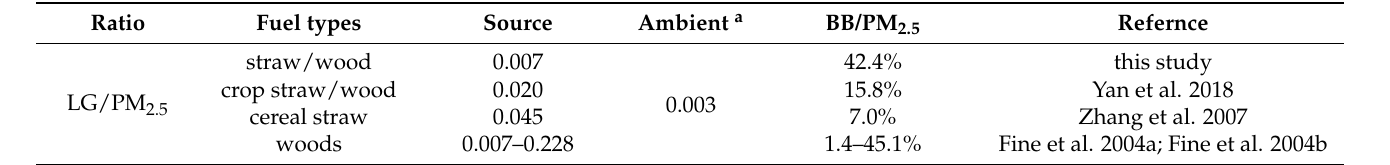
Table 5. The contribution of BB to PM 2.5 under different source